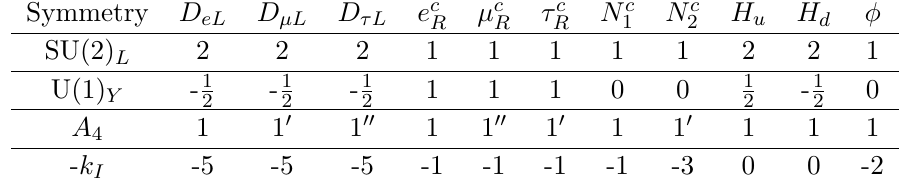
Table 1 . Field content of the model and charge assignments under SU(2) L , U(1) Y , A 4 including modular weights.